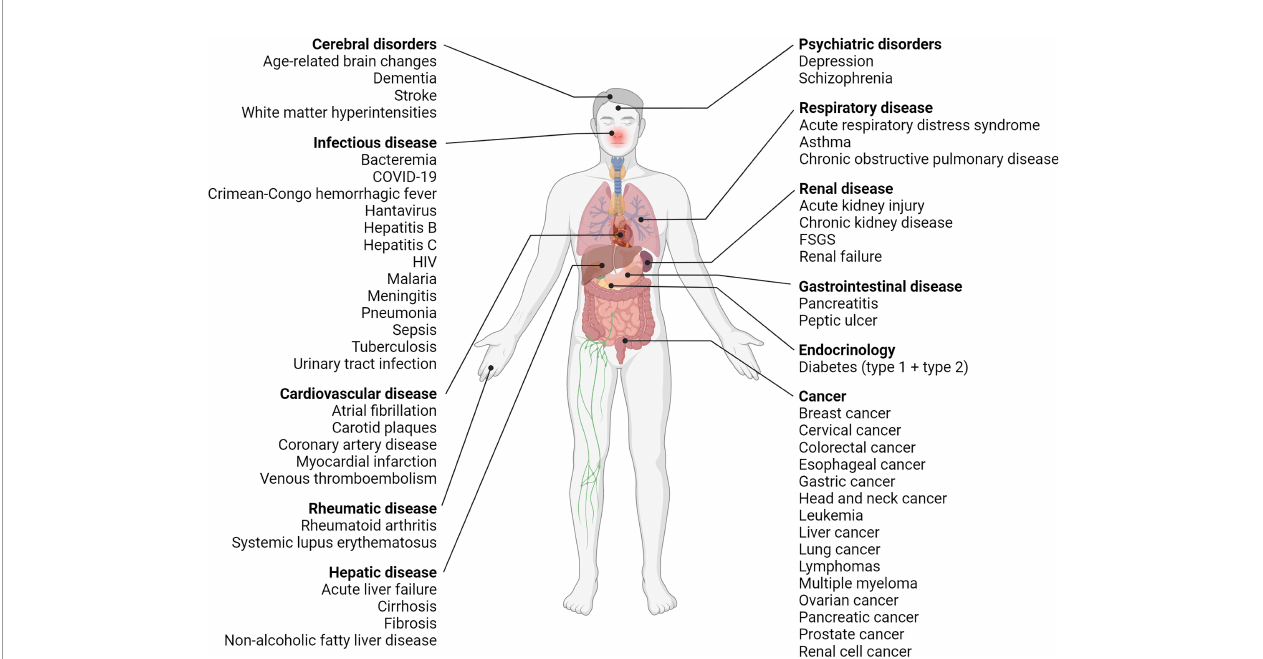
FIGURE 4 | Overview of diseases with elevated suPAR levels. Clinical studies have shown that suPAR levels are elevated and associated with disease severity and prognosis in many diseases, including diseases of the brain, liver, kidneys, and respiratory system, cardiovascular disease, diabetes (type 1 and type 2), cancer as well as infectious, rheumatic, and psychiatric disorders. COVID-19, coronavirus disease 2019; FSGS, focal segmental glomerulosclerosis; HIV, human immunode fi ciency virus; suPAR, soluble urokinase plasminogen activator receptor. Created with